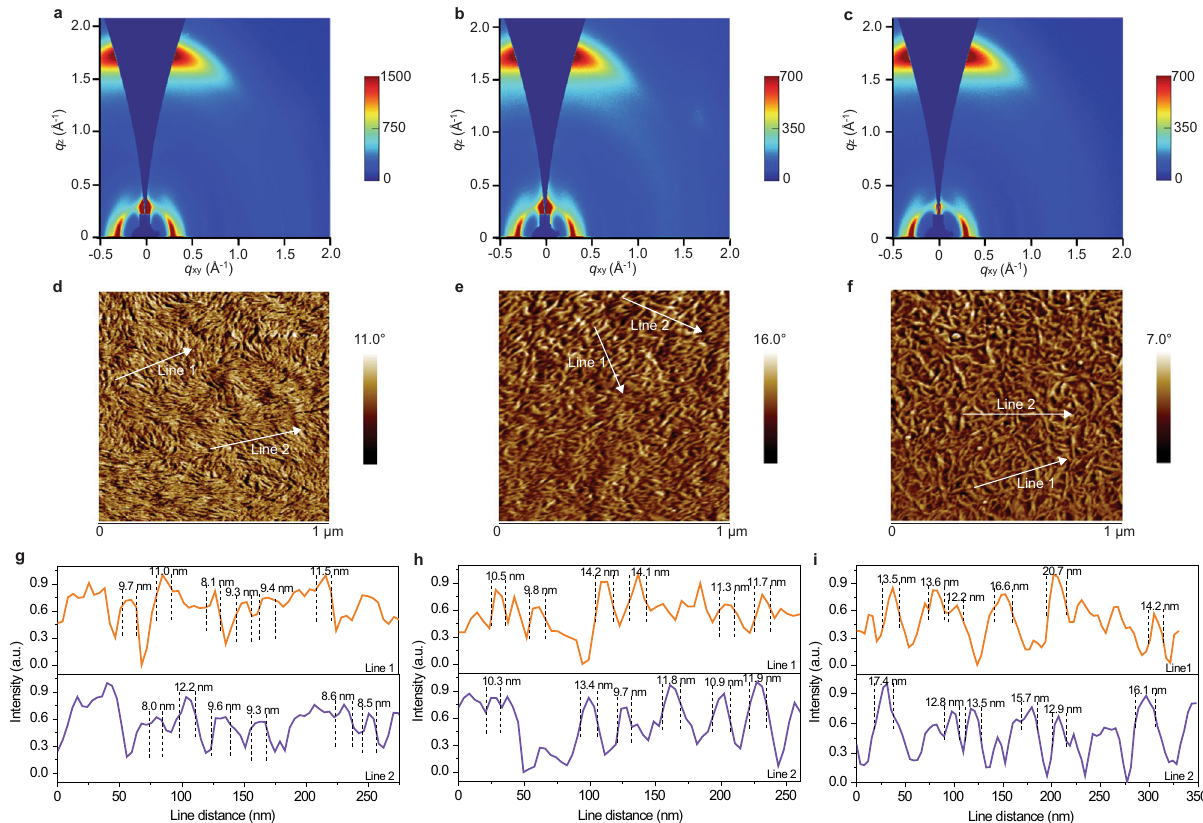
Fig. 4 Morphology characterizations. a – c 2D GIWAXS patterns of the ( a ) PM6:BTP-eC9 blend, b PM6:BTP-eC9:L8-BO-F blend, and ( c ) LBL-processed PM6:BTP-eC9:L8-BO-F blend with 300 nm thickness. d – f AFM phase images of ( d ) PM6:BTP-eC9 blend, e PM6:BTP-eC9:L8-BO-F blend, and ( f ) LBL- processed PM6:BTP-eC9:L8-BO-F blend with 300 nm thickness. g – i The line pro fi les to obtain the FWHM of cross-sections though AFM signals of ( g ) PM6:BTP-eC9 blend, h PM6:BTP-eC9:L8-BO-F blend, and ( i ) LBL-processed PM6:BTP-eC9:L8-BO-F blend (two lines are selected to calculate the